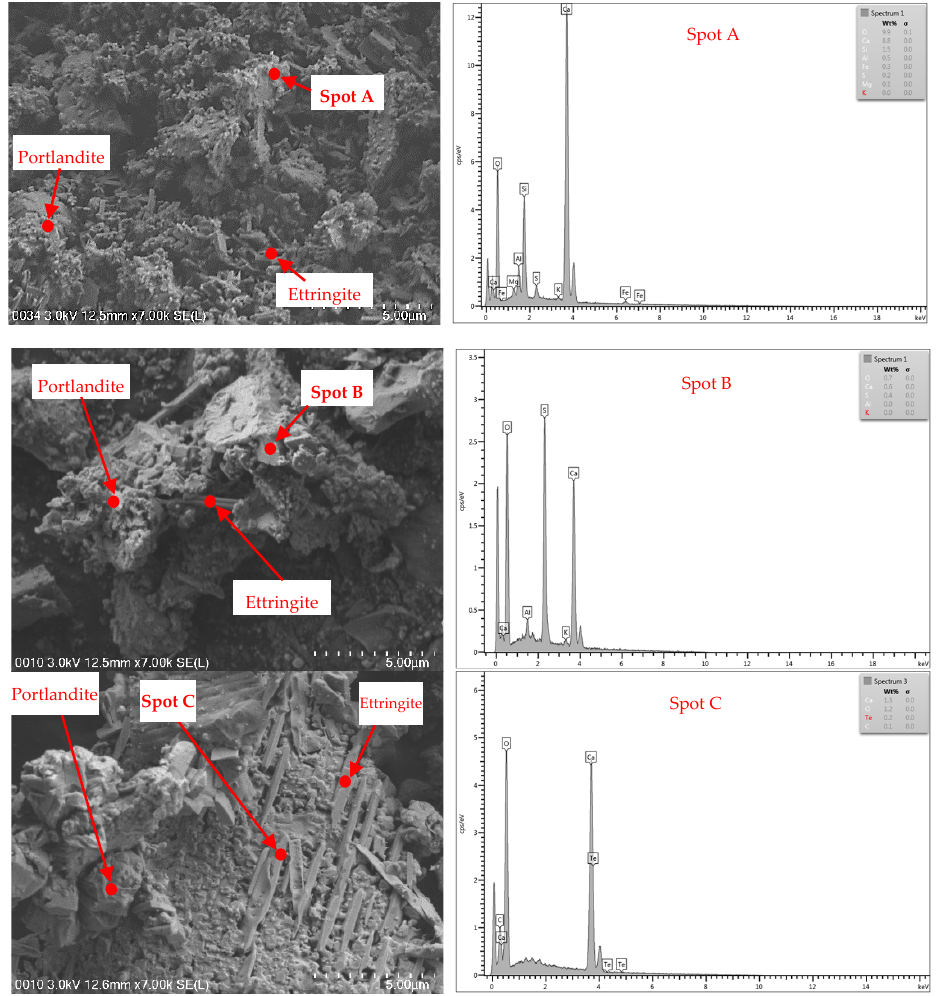
Figure 11. FESEM and EDX images of unheated and heated cements: Unheated cement at ambient temperature ( top row ); Heated cement at 600 °C ( middle row ); and, Heated cement at 1000 °C ( bottom row ).